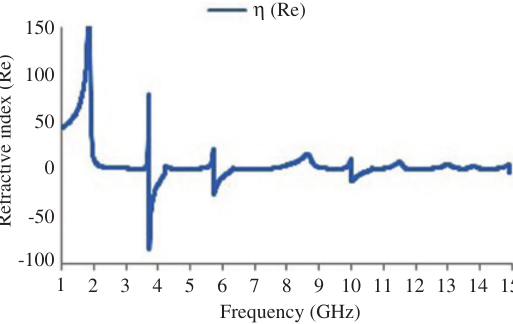
Figure 7: Real value of refractive index ( η ) versus frequency for the x -axis wave propagation.